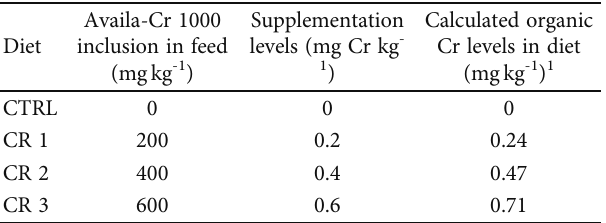
Table 3: Supplementation of diets with Availa-Cr 1000: supplemented and calculated levels of